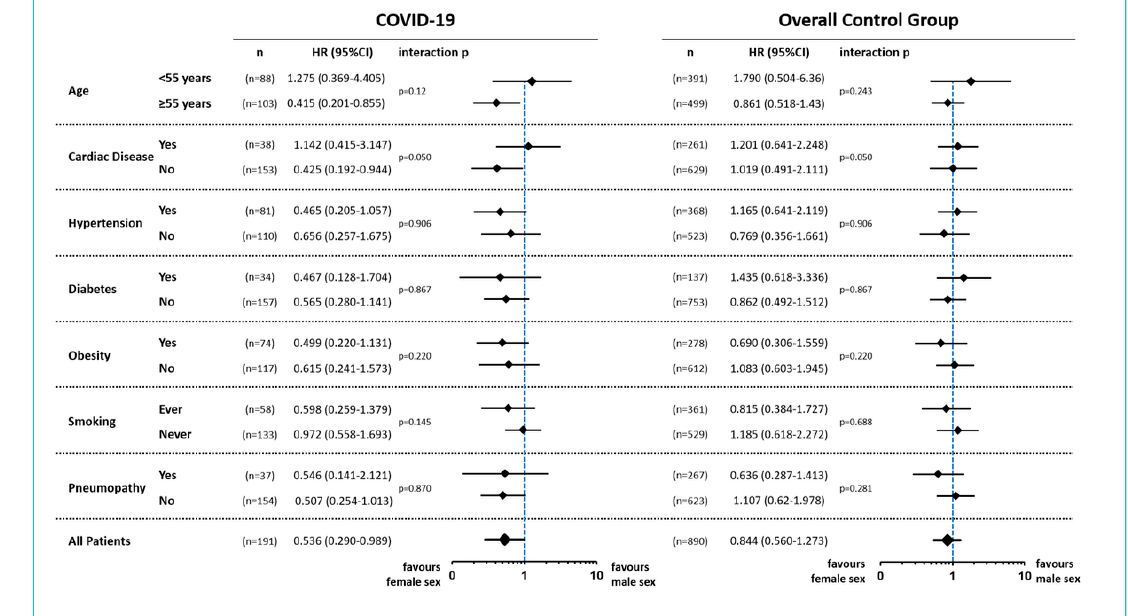
Figure 3: Forest plot showing age-adjusted hazard ratios (HR) and their corresponding 95% confidence intervals to quantify the impact of sex on the composite primary outcome in predefined subgroups within the COVID-19 cases (first column) and the controls (second column)